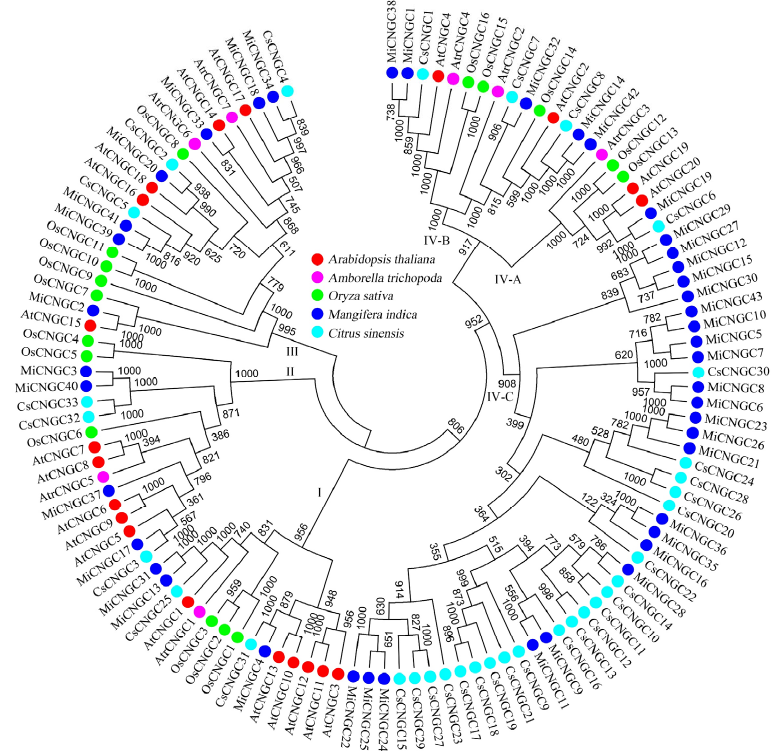
Figure 2. Maximum-likelihood phylogenetic tree of CNGC proteins in Arabidopsis thaliana (red), Amborella trichopoda (pink), Oryza sativa (green), Mangifera indica (blue) and Citrus sinensis (light blue).